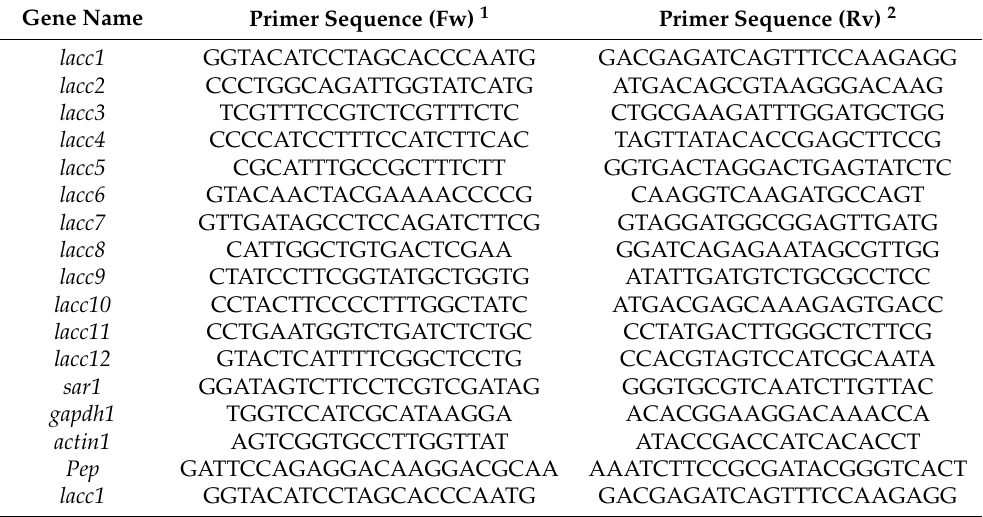
Table 1. Forward and reverse primers sequence to for the laccase and reference genes